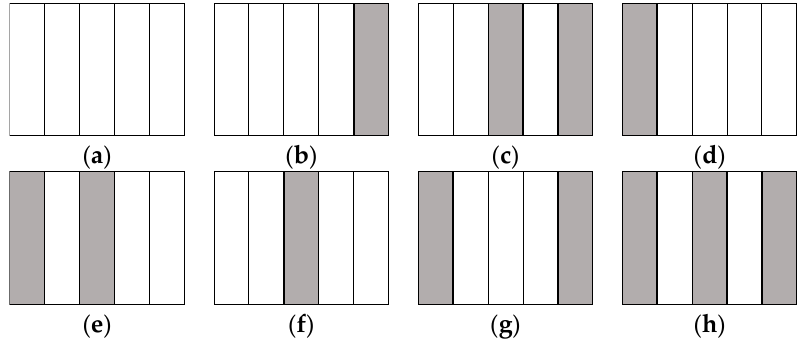
Figure 5. Correa’s eight obstacles scenarios. ( a ) No obstacle; ( b ) One obstacle at the far right; ( c ) Two obstacles at the right, separated by a gap; ( d ) One obstacle at the far left; ( e ) Two obstacles at the left, separated by a gap; ( f ) An obstacle at the middle; ( g ) Two obstacles at the far right and far left; ( h ) Three obstacles separated by two gaps.